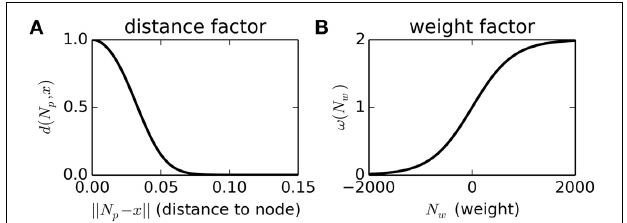
FIGURE 2 | The influence of a single node. This plot shows the combined influence of single node, located at N p = (0 . 5 , 0 . 5) with N v = (0 , 0 . 1) in a hypothetical 2-motor, 0-sensor IDSM. The N v is exactly vertical, so all horizontal motion is due to the attraction factor, and vertical motion is due to the velocity factor. See Equations (6–9) and main text for